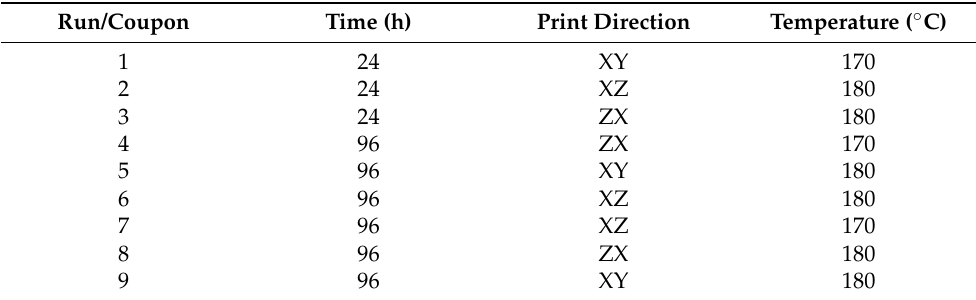
Table 3. Modified L9 Orthogonal Array used in this experiment, with the respective factor levels from Table 2.